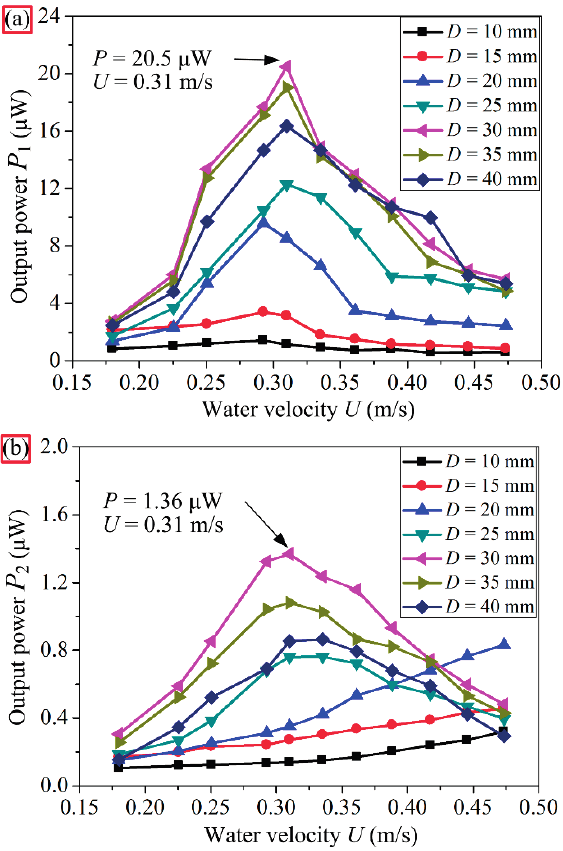
Figure 6. Energy harvesting performance versus water velocities with different cylinder diameters: ( a ) upstream beam; ( b ) downstream